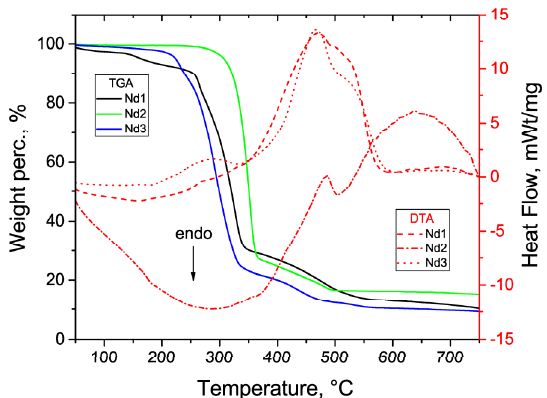
Figure 5. TGA and DTA curves of complexes Nd1 , Nd2 and Nd3 .